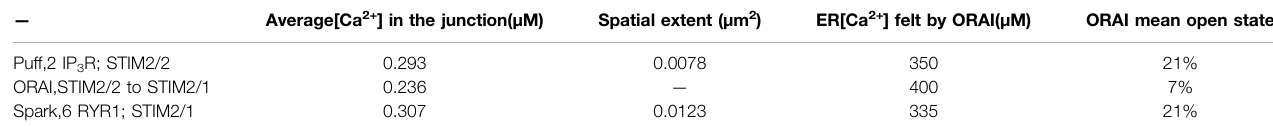
TABLE2| Characteristicsofthesimulatedmicrodomains correspondingtoIP 3 -dependentCa 2+ signalingstimulatedbyTcelladhesion (line1),toaspontaneousopeningof ORAI in the absence of stimulation (line 2) or to NAADP-dependent Ca 2+ signaling in response to TCR/CD3 stimulation (line 3) — Average[Ca 2+ ] in the junction( μ